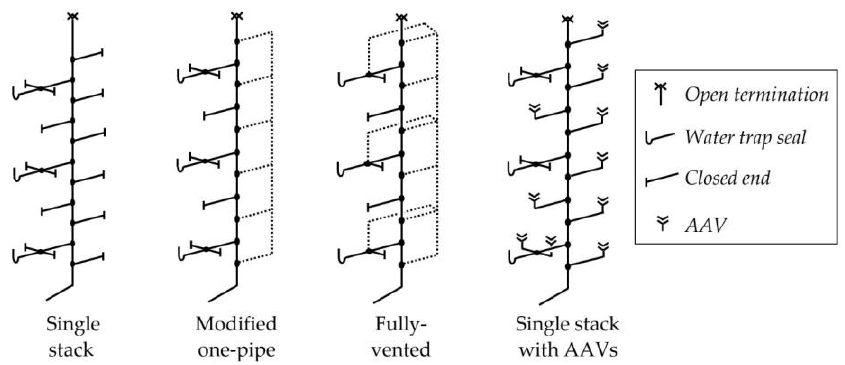
Figure 4. System configurations used for numerical simulation (not to scale).